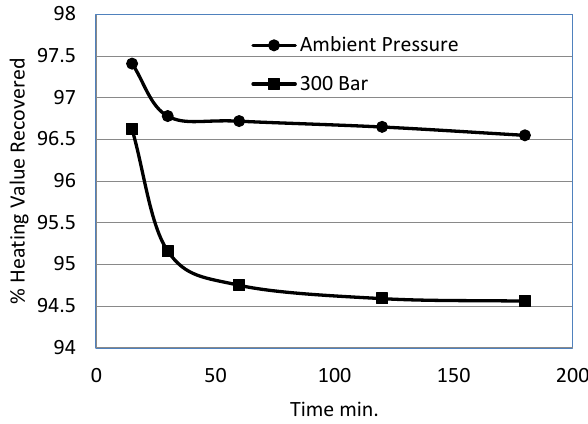
Time min. Figure 15. Effect of time on heating value Figure 15. Effect of time on heating value recovery. Figure 15. Effect of time on heating value recovery.